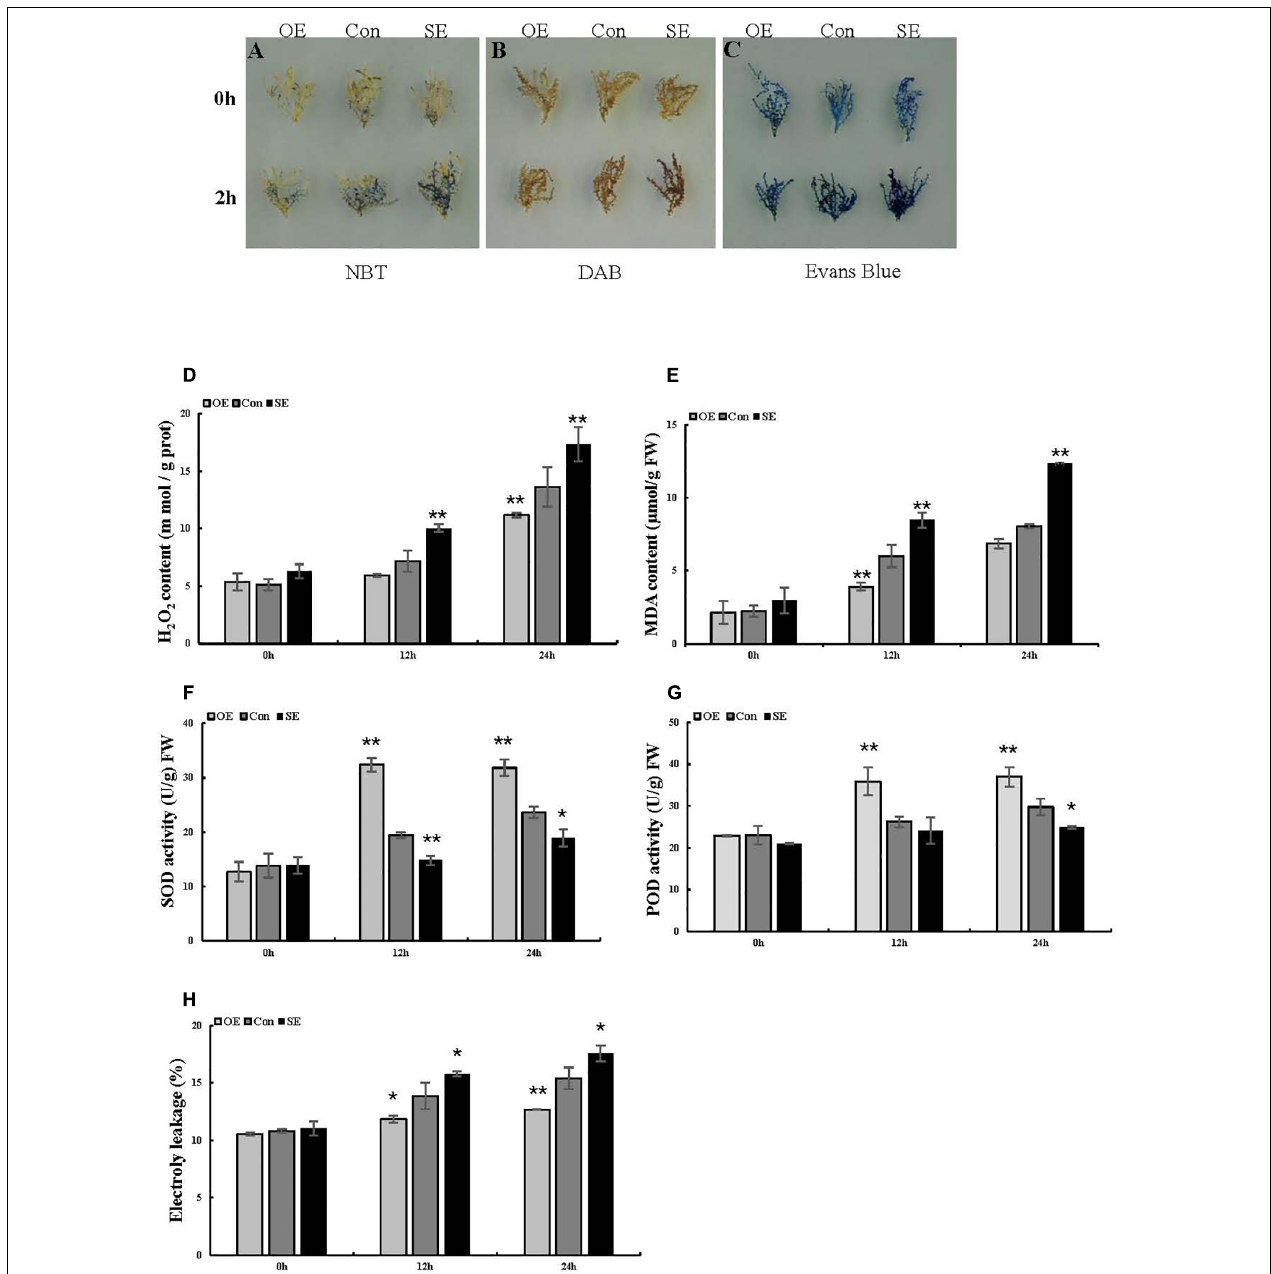
FIGURE 4 | Analysis of ROS-scavenging capability and cell death in T. hispida plants with overexpression or RNAi-mediated knockdown of ThSOS3 . (A) NBT and (B) DAB staining were performed to detect O 2 - and H 2 O 2 , respectively. (C) Evans blue staining was used to analyze cell death. Young branches from transformed T. hispida plants treated with 150 mM NaCl for 2 h were used for DAB, NBT, and Evans blue staining. (D–H) Analysis of H 2 O 2 and MDA content, SOD and POD activity, and electrolyte leakage in three different transgenic T. hispida plants. Transformed T. hispida plantlets grown on 1/2 MS solid medium supplemented with 150 mM NaCl for 24 h were used to measure the H 2 O 2 (D) and MDA (E) content, SOD (F), and POD (G) activity, and electrolyte leakage (H) . *Represents a significant difference ( P < 0.05). **Represents a very significant difference ( P <